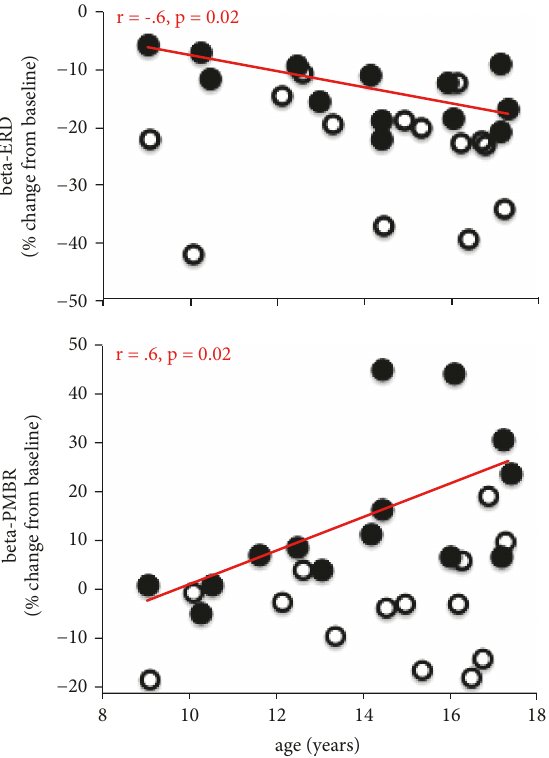
Figure 5: Beta correlation results. Representative plots of the correlation results assessing the relationship between age of the subjects and contralateral beta-ERD (top) and -PMBR (bottom) power during index imitation. The r values were -.6 for ERD and .6 for PMBR for control participants (closed black circles, red trendline). No significance was found for ASD participants (open black circles) for both ERD and